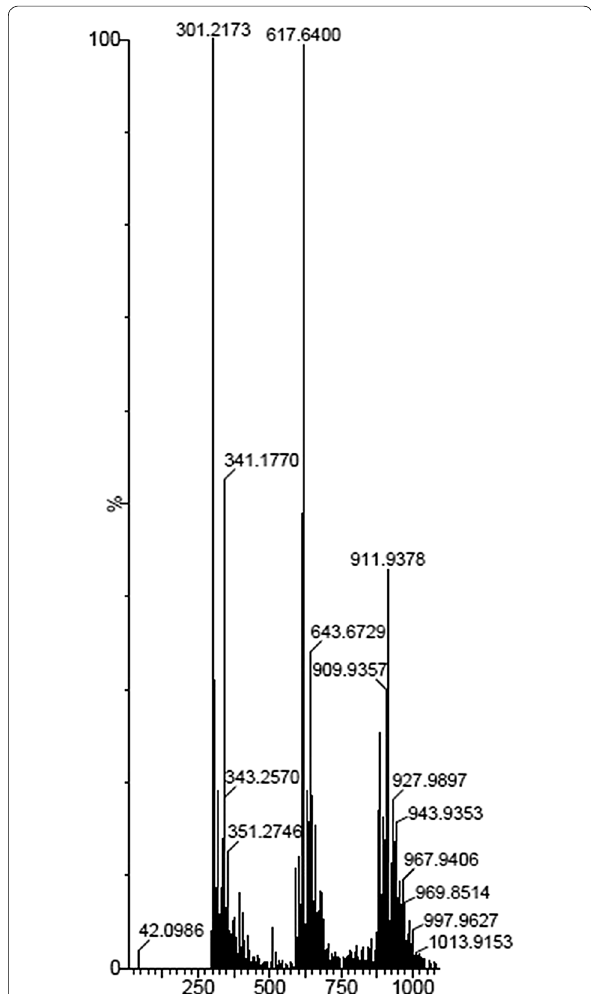
Fig. 3 Mass spectral trace of sa - um by ESI + -MS method. m/z: 300-351-monoacyl glycerol, with higher intensity around m/z: 300– 304 region due to arachidonic acid, typical fatty acid of non-ruminant species; m/z: 550–650-diacyl glycerol species; m/z: 750–850-triacyl glycerol species; with a modest levels of triacyl phospholipid species in the m/z: 900 region, due to smaller quantity of muscle adipose tissues in sa -